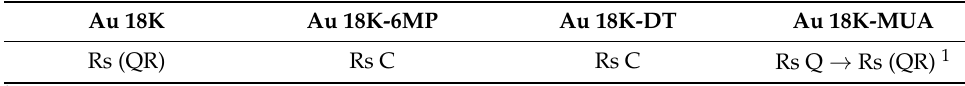
Table 5. Equivalent circuits of Au 18K and derivative SAMs.